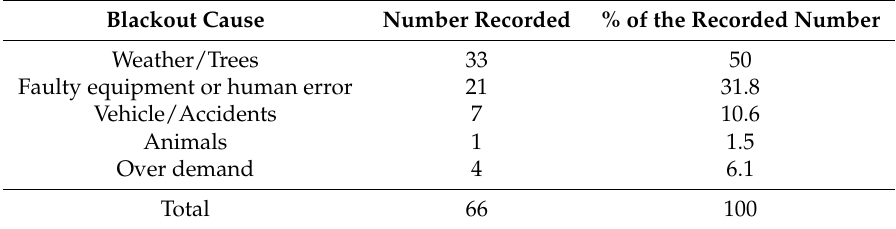
Table 7. Analysis on blackouts around the globe and their percentage from 2011 to 2019. Blackout Cause Number Recorded % of the Recorded Number